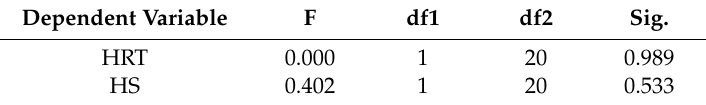
Table 4. Levene’s test of the homogeneity of variances.